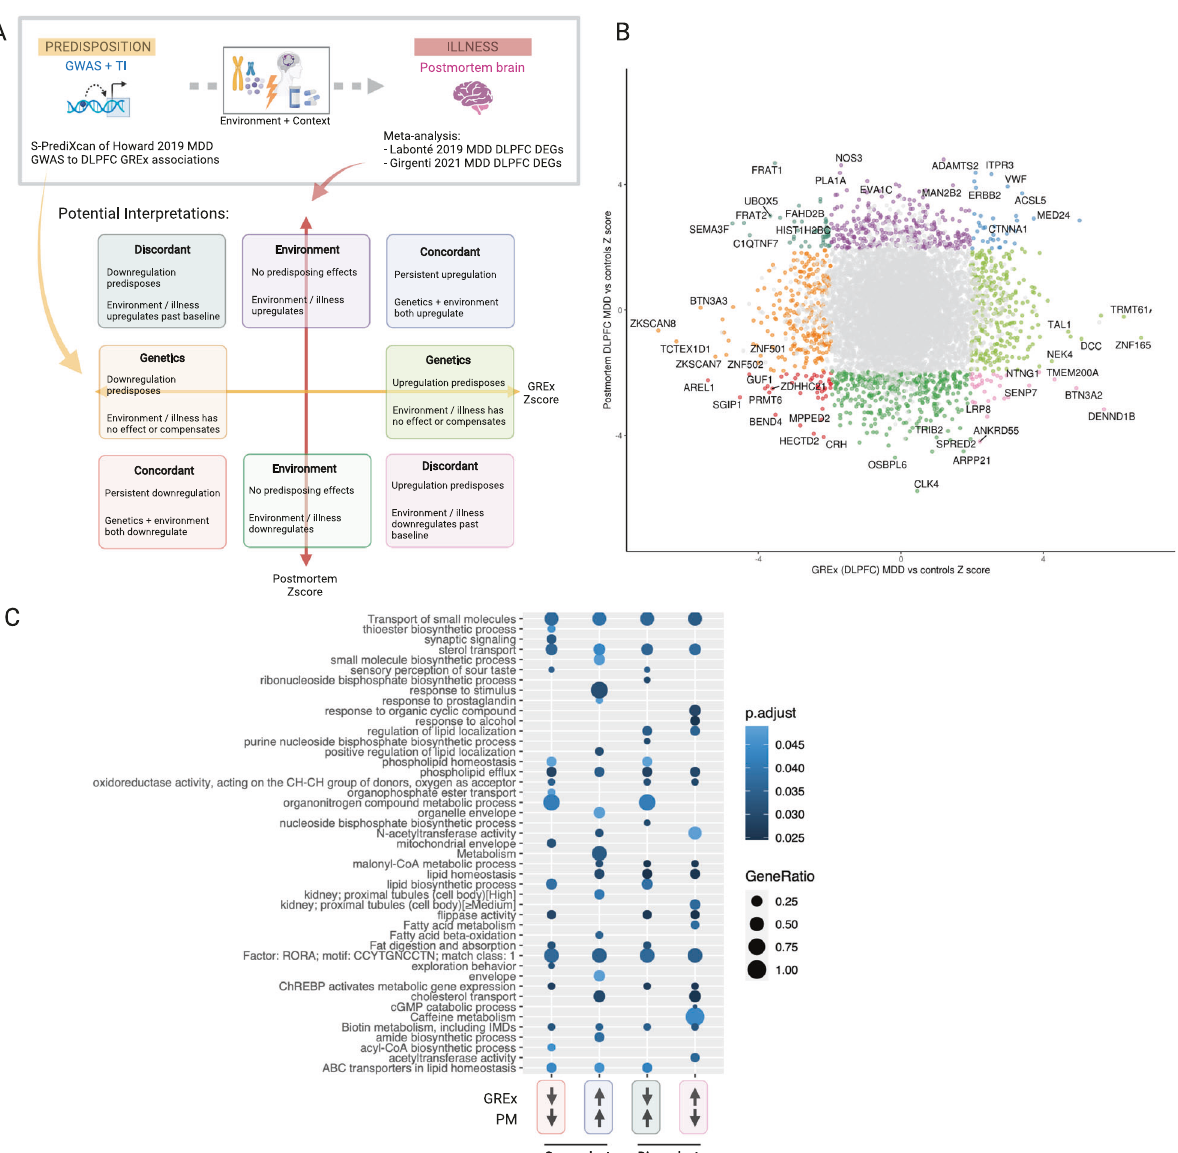
Fig. 3 Mapping gene-level associations for depression from predisposition to illness. A Conceptual representation of analysis and potential interpretations for dynamic MDD gene expression associations. Predisposition: dorsolateral prefrontal cortex (DLPFC) genetically regulated expression associations were predicted with S-PrediXcan using MDD GWAS [3] and CommonMind Consortium DLPFC eQTL predictor model [71]. Illness: MDD vs healthy control differentially expressed genes [3, 4] were meta-analyzed using a fi xed-effects inverse variance method. B Z -scores for GREx (predisposition) and postmortem (illness) associations of MDD vs controls are plotted. C Gene set enrichment (g:Pro fi ler [155]) of top concordant and discordant genes ( p < 0.05) from analysis in ( B ). GREx genetically regulated expression, PM postmortem. Created with